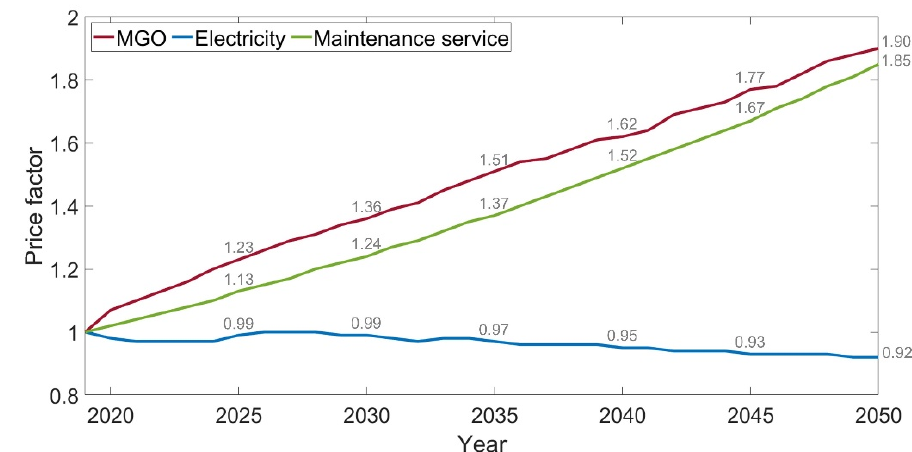
Figure 9. Parameter price projections over the ship lifetime.